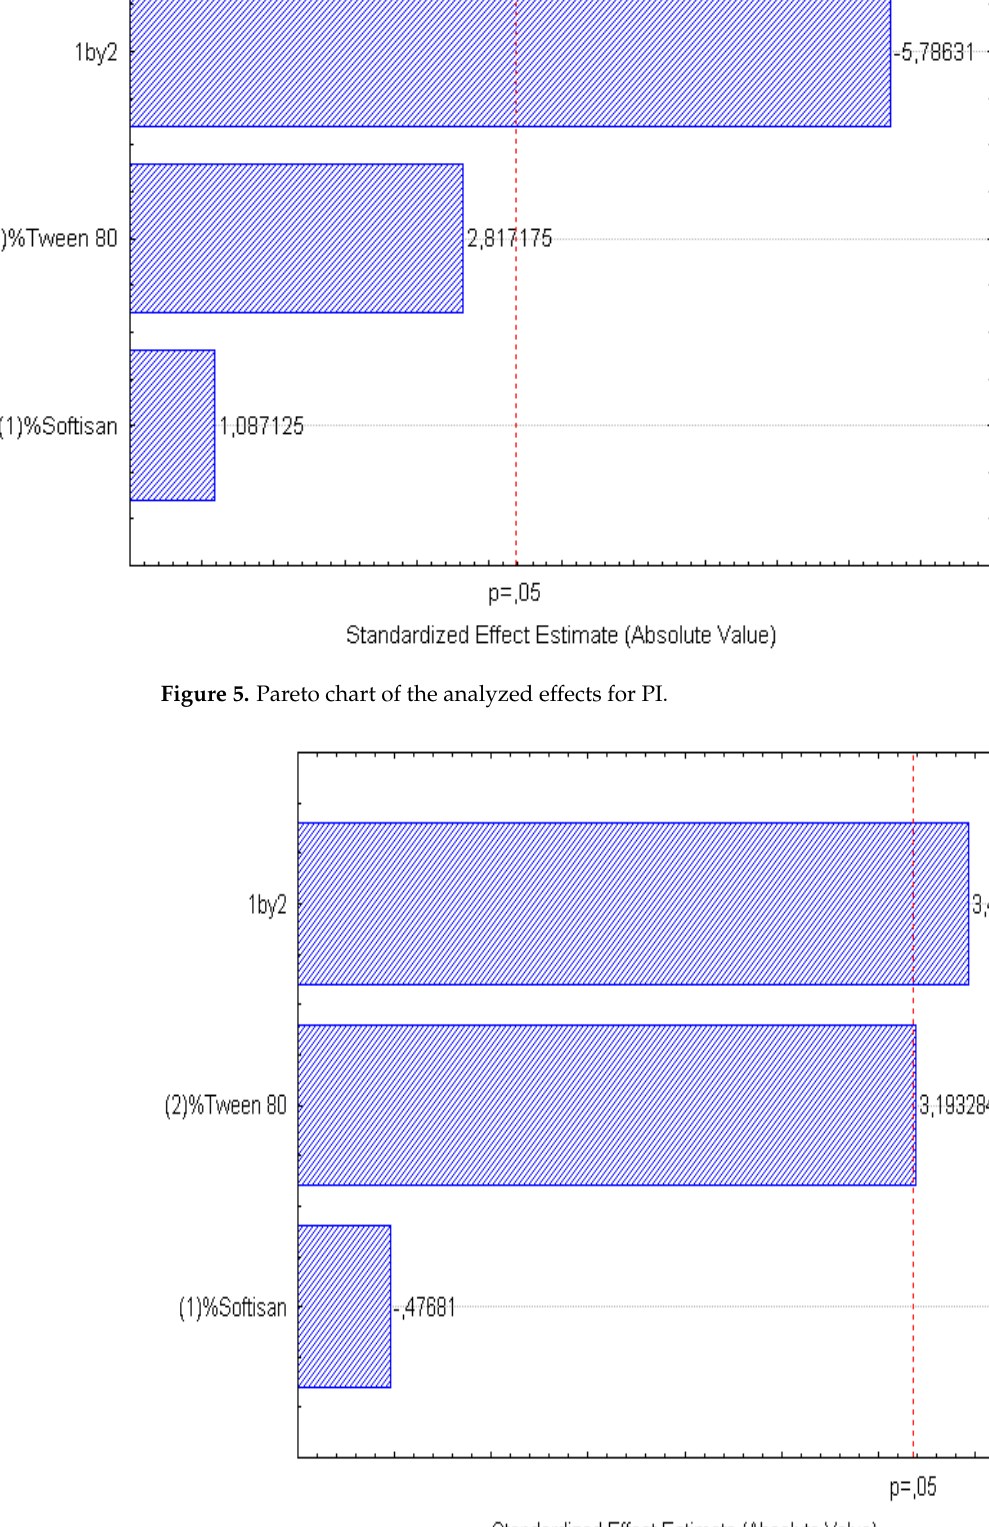
Figure 6. Pareto chart of the analyzed effects for